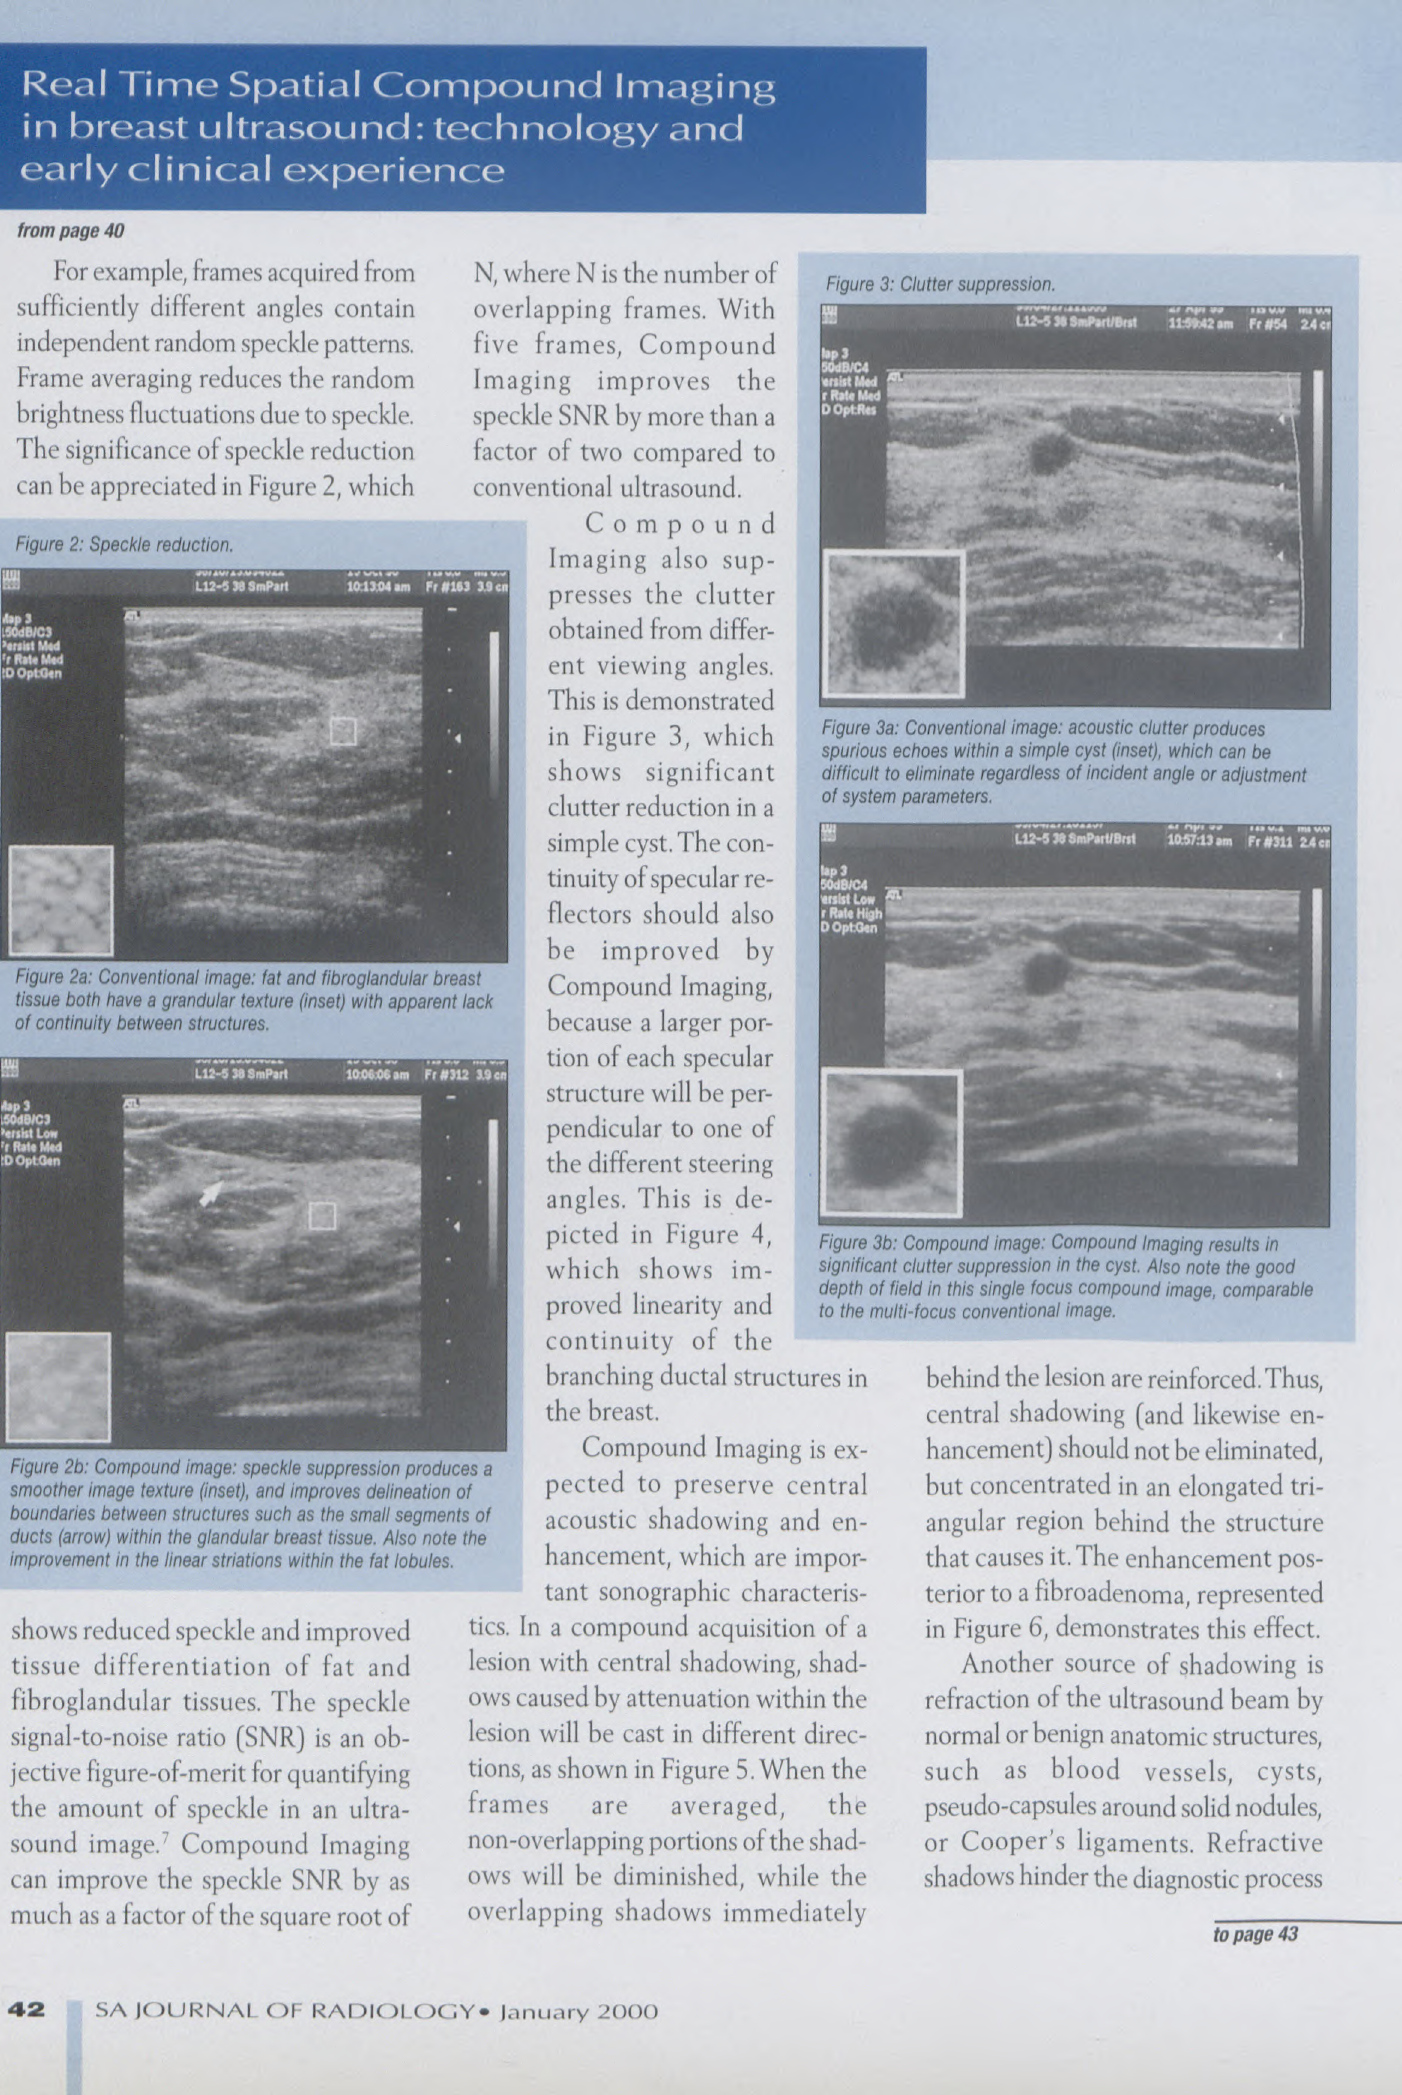
Figure 3: Clutter suppression.